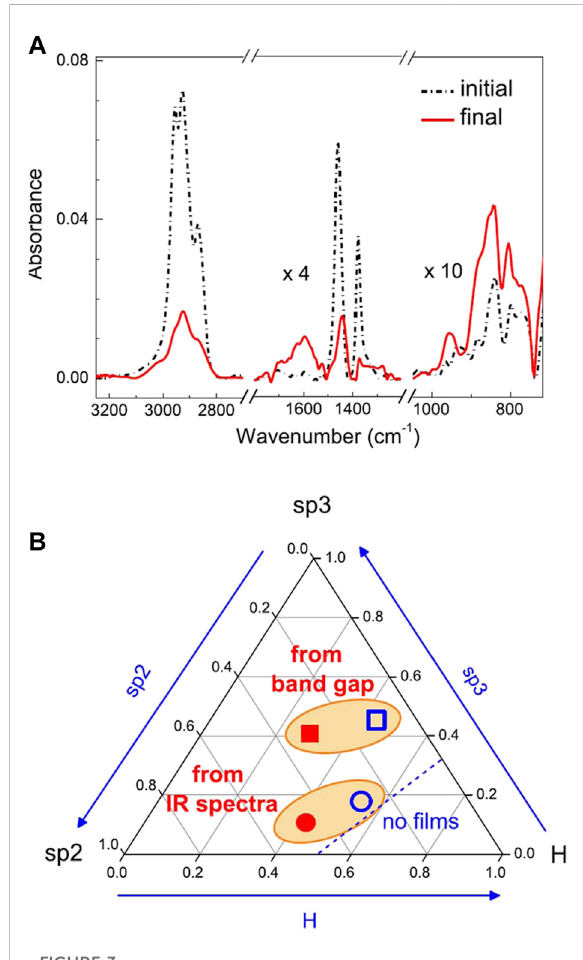
FIGURE 3 (A) Black dashed curve: infrared spectrum of an a-C:H interstellar dust analog deposited in an RF discharge of CH 4 /He (thickness 570 nm). Red curve: infrared spectrum of the same sample after irradiation by 5 keV electrons ( fl uence 2 × 10 7 electrons cm − 2 ). (B) : Ternary diagram for a-C:H, with estimates of the atomic composition of the samples in (A) . Open symbols: unprocessed deposit. Closed symbols: deposit after electron irradiation. Two different methods are used for the estimation (see thetext).ReproducedfromPeláez etal., 2018, Plasma Sources Sci. Technol. 27,